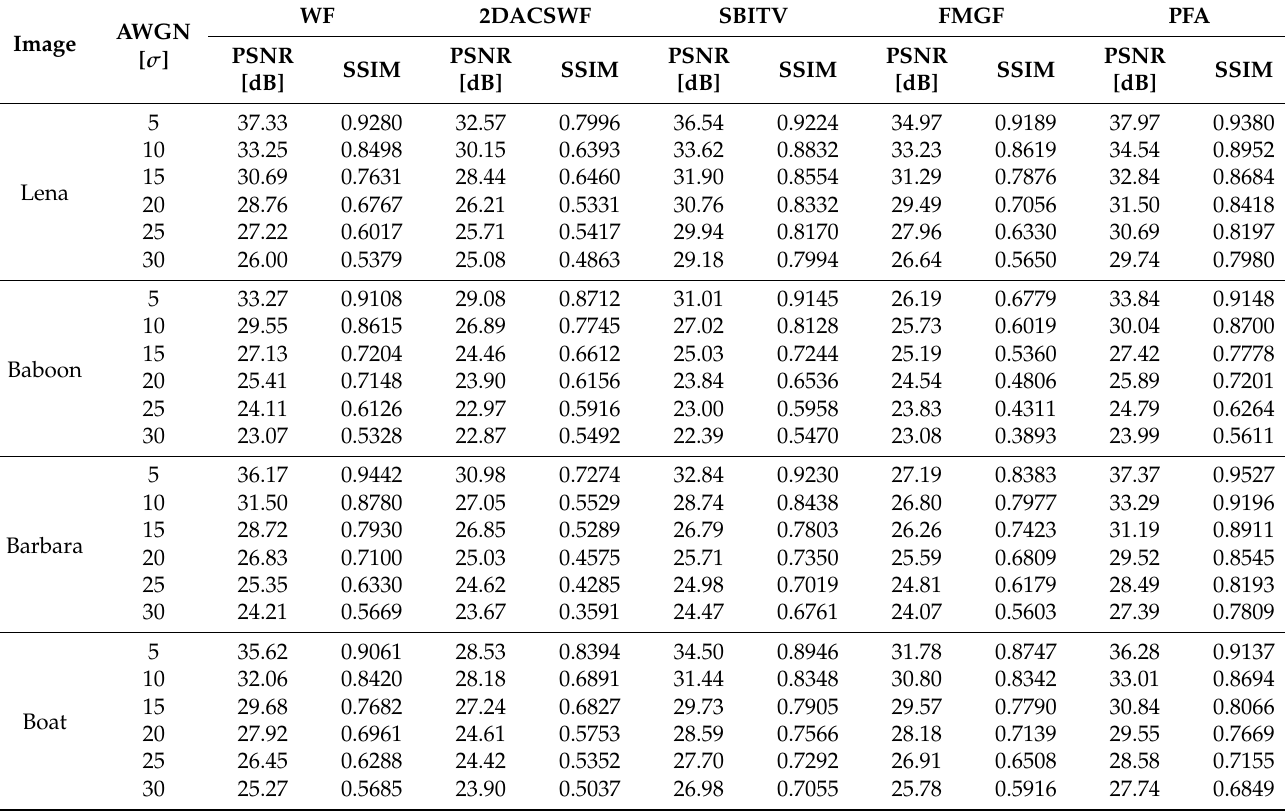
Table 2. Comparison of PSNR and